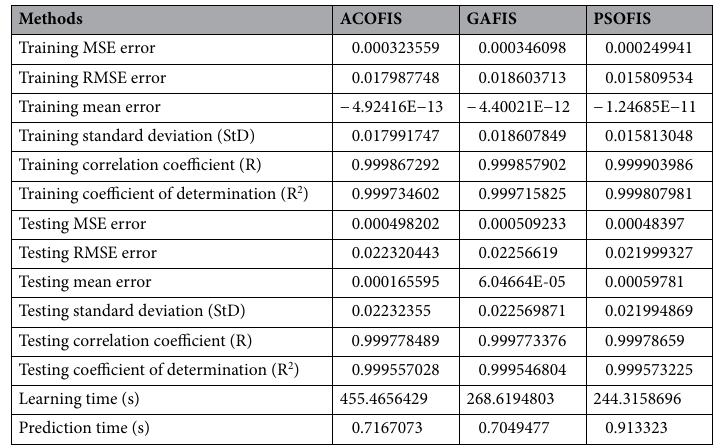
Table 2. Different error approaches (training and testing processes), learning and prediction times for ACO, GAFIS, PSOFIS